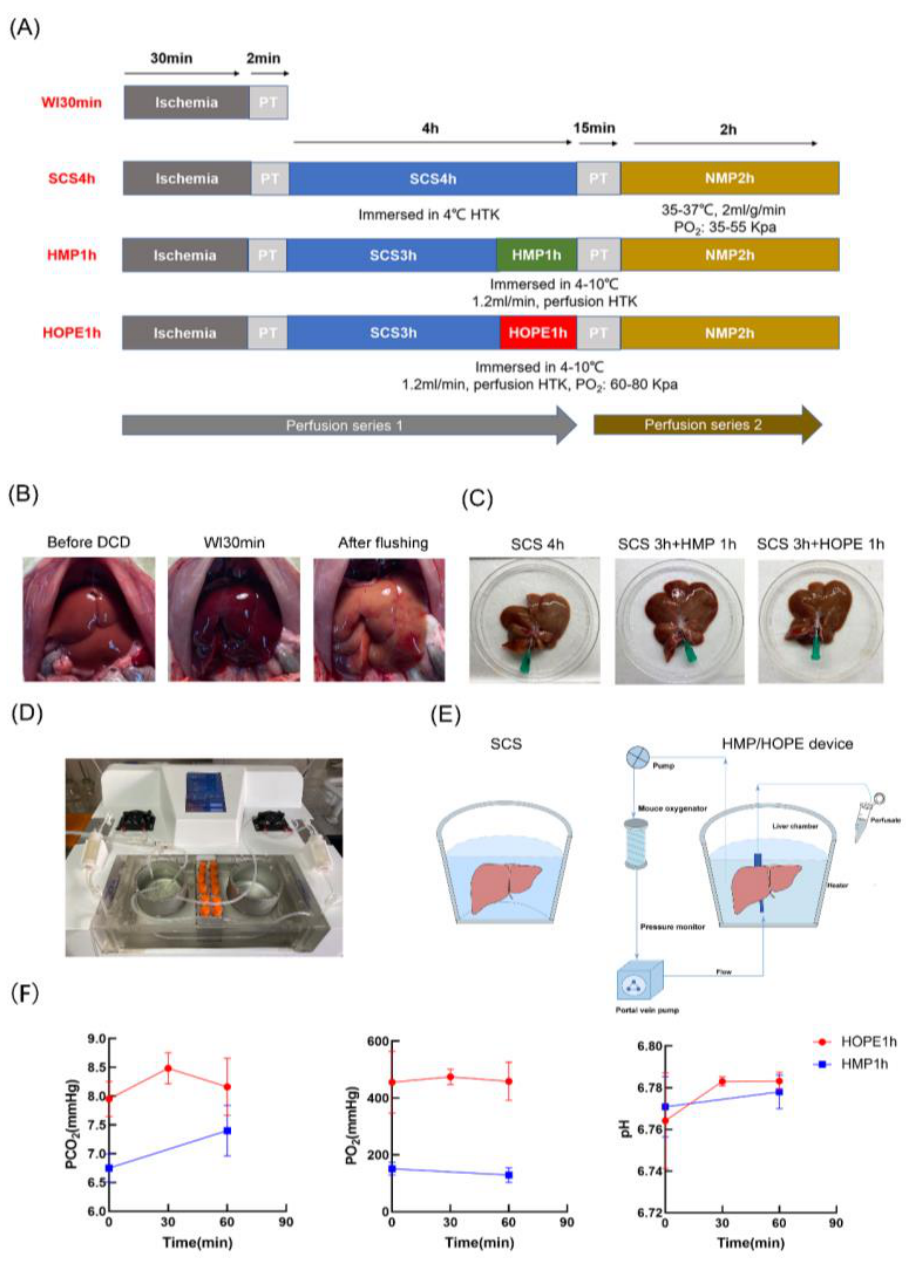
Figure 1. Four groups’ experimental protocols. ( A ) Perfusion series 1: liver subjected to 30 min warm ischemia in situ, flush, and static cold storage; and HMP or HOPE after static cold storage ( n = 6 each). Perfusion series 2: livers except WI 30 min were perfused for 2 h using NMP to determine liver function and injury ( n = 3 each). ( B ) Liver appearance before warm ischemia for 30 min and flush. ( C ) Liver morphology in three different hyperthymic storage or machine perfusion methods in perfusion series 1. ( D ) The machine system stored the livers and performed machine perfusion. ( E ) Schematic representation of SCS and MP devices. ( F ) The parameters of pH, PO 2 , and PCO 2 of hyperthymic machine perfusion were calculated.